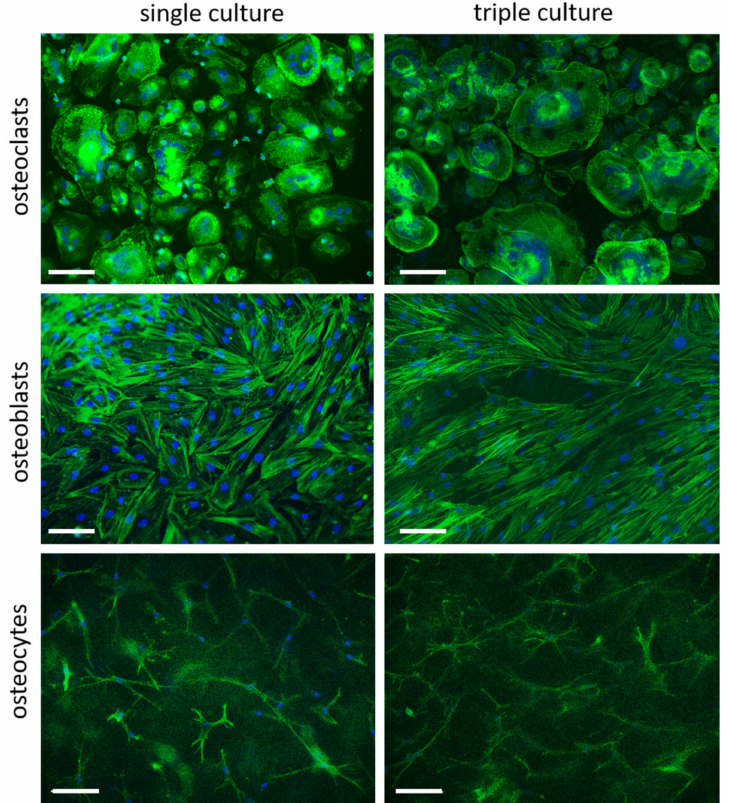
Figure 2. Fluorescence microscopic images of osteoblasts and mature osteoclasts seeded on the porous PET membrane, as well as osteocytes, embedded in collagen I gels after 7 days in single and triple culture, respectively. Scale bars represent 100 µ m. Nuclei appear in blue, cytoskeleton in